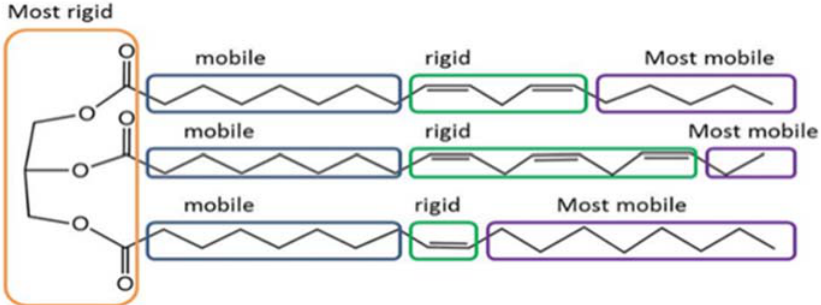
Figure 2. Scheme of triacylglycerol oil structure and segmental motion assigned by segmental rigidity and mobility tests [34].